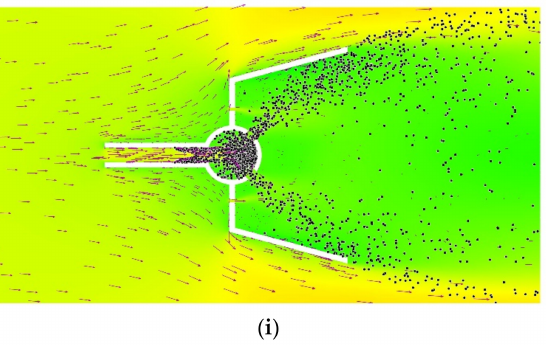
Figure 12. Spray field under different actuation intensities with 20 mm actuation length on inner surface: ( a ) 85kV, 14kHz, ( b ) 85kV, 9kHz, ( c ) 85kV, 5kHz, ( d ) 45kV, 14kHz, ( e ) 45kV, 9kHz, ( f ) 45kV, 5kHz, ( g ) 5kV, 14kHz, ( h ) 5kV, 9kHz, ( i ) 5kV, 5kHz.